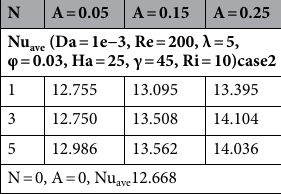
Table 4. Effect of N and A on the average Nusselt number for Case 1.